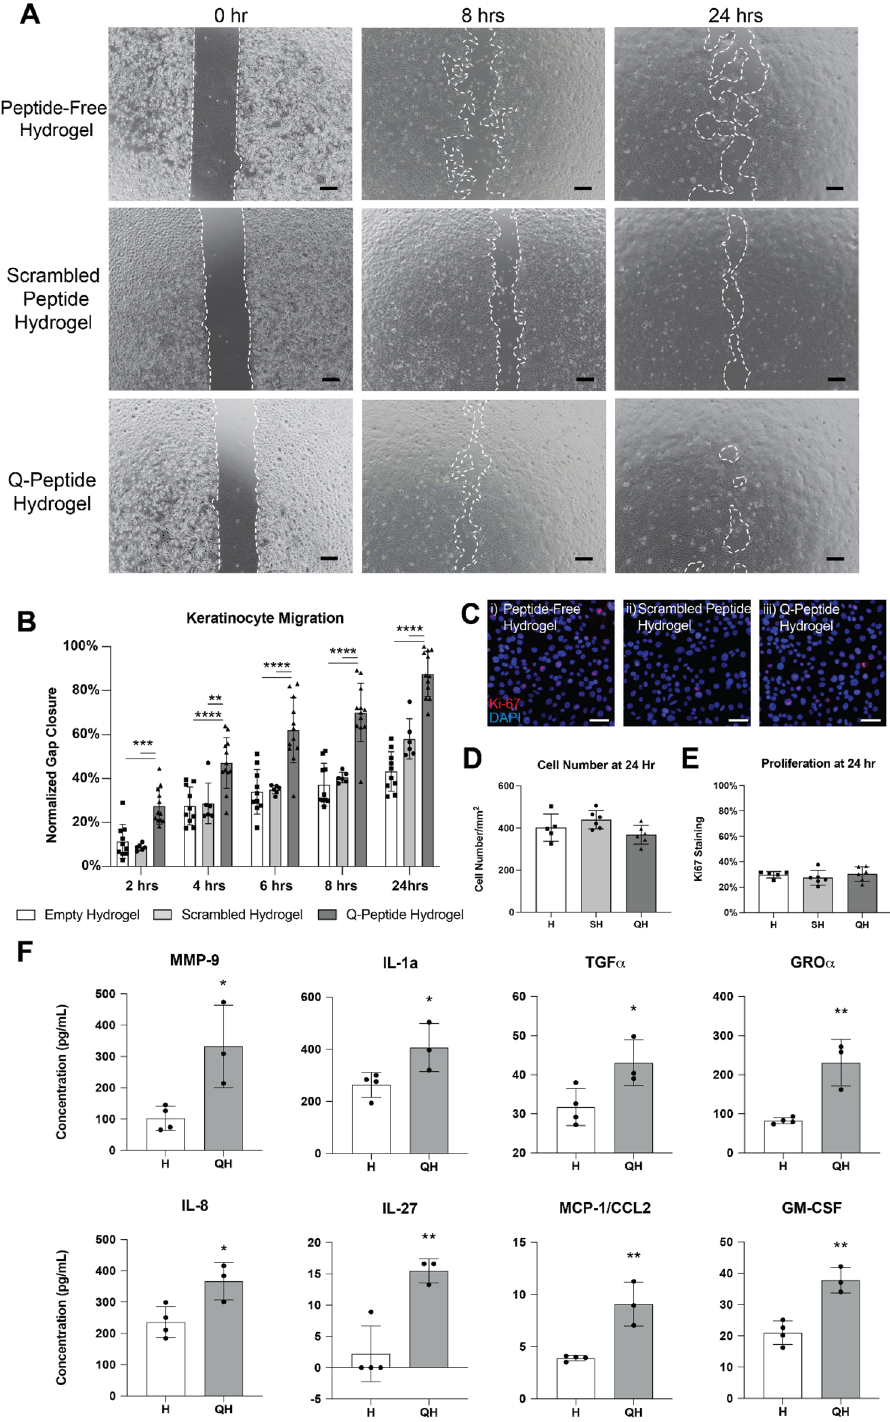
Figure 1. Accelerated normal adult human keratinocyte (HEKa) migration and altered cytokine profile are observed on QHREDGS peptide conjugated collagen-chitosan film (Q-Peptide Hydrogel). ( A ) Representative examples of wound simulation assay using HEKa cells adhered to hydrogel film without conjugated peptide, with scrambled Q-Peptide, and with QHREDGS peptide after 24 h (scale bars: 200 μm). ( B ) HEKa migration (relative to initial gap area) in the presence of Q-Peptide Hydrogel (dark grey; n = 12) was accelerated in comparison to the collagen-chitosan film without peptide conjugation (Peptide-free hydrogel; white; n = 11), and the scrambled peptide Hydrogel (light grey; n = 6). ( C ) Representative images of HEKa cells stained with Ki-67 (red) and counterstained with DAPI (blue) after 24 h (scale bars = 100 μm). ( D ) Quantification of cell number as indicated by DAPI staining demonstrates no difference in cell density at 24 h. ( E ) Quantification of % positive Ki-67 staining revealed no significant difference between cells cultured on the Q-Peptide Hydrogel (QH) and the peptide-free hydrogel. ( F ) Human cytokine array on media collected after migration assay conducted on Peptide-free hydrogel and Q-Peptide Hydrogel. Concentration (pg/mL) expressed after subtraction of baseline media. n = 3. H = Peptide-Free Hydrogel, SH = Scrambled Peptide Hydrogel, QH = Q-Peptide Hydrogel. Data are presented as mean ± SD. ** p <